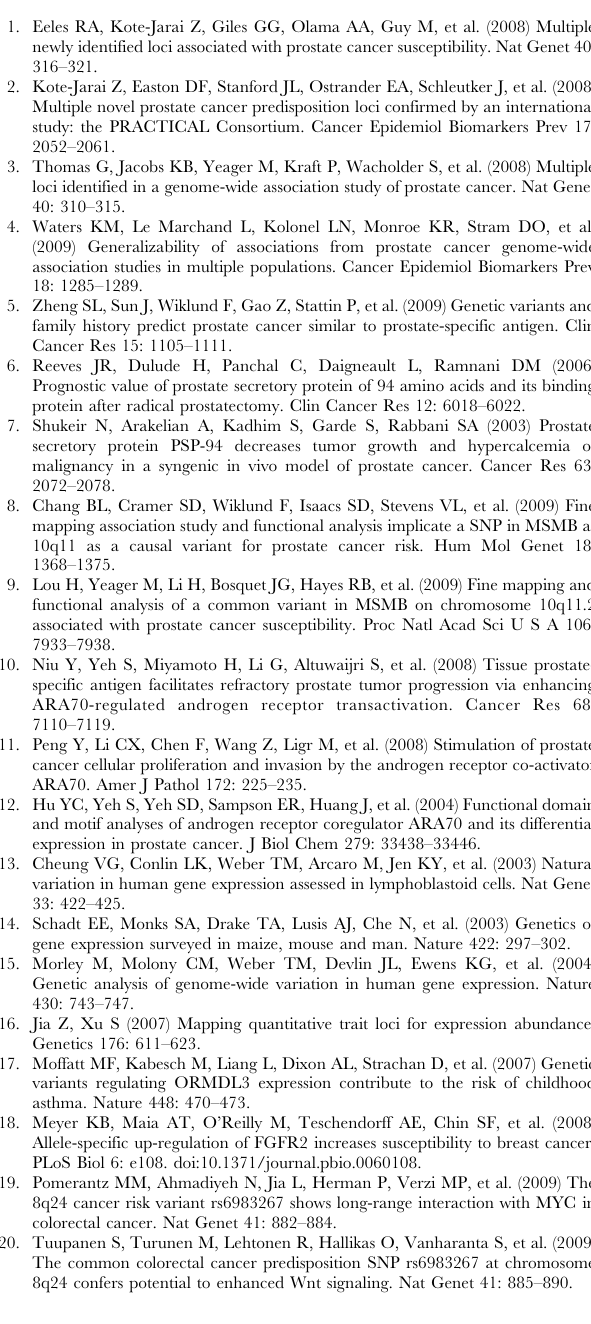
Figure S5 Anchorage-independent growth in human mammary epithelial cells. MSMB and NCOA4 expression levels do not consistently affect anchorage-independent growth of human mammary epithelial cells (HMLE). A. Suppression of MSMB by three independent shRNAs (p-values 0.0949, 0.7482, and